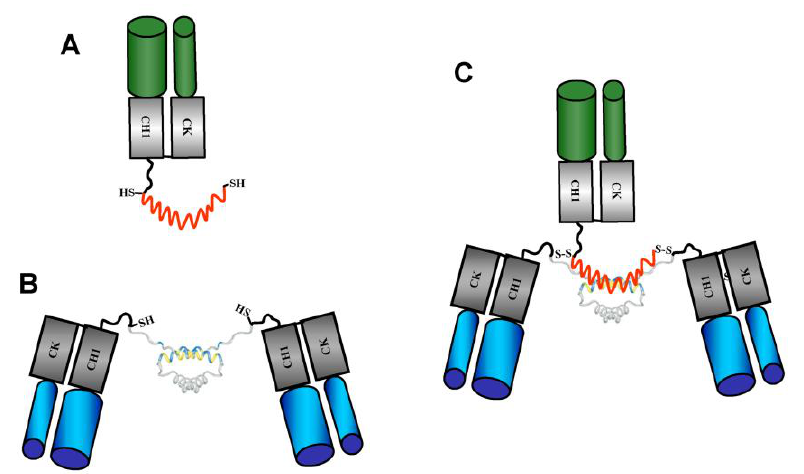
FIGURE 1. Representations of h679-AD2 (A), C-DDD2-hMN-14 (B), and the bispecific tri- Fab fusion protein, TF2 (C), prepared by the DNL method. In this, one Fab fragment, derived from humanized 679 MAb with binding specificity for HSG, is attached to the AD2 peptide. Two Fabs are derived from humanized MN-14 MAb, with binding specificity for CEACAM5, and are on the DDD dimer. Noncovalent binding between the functionalized DDD2 and AD modules and the subsequent locking disulfide formations lead to the stable TF2 fusion protein. Reproduced from Figure 2, Rossi et al.[22], with permission. Copyright 2006 by the National Academy of Sciences,